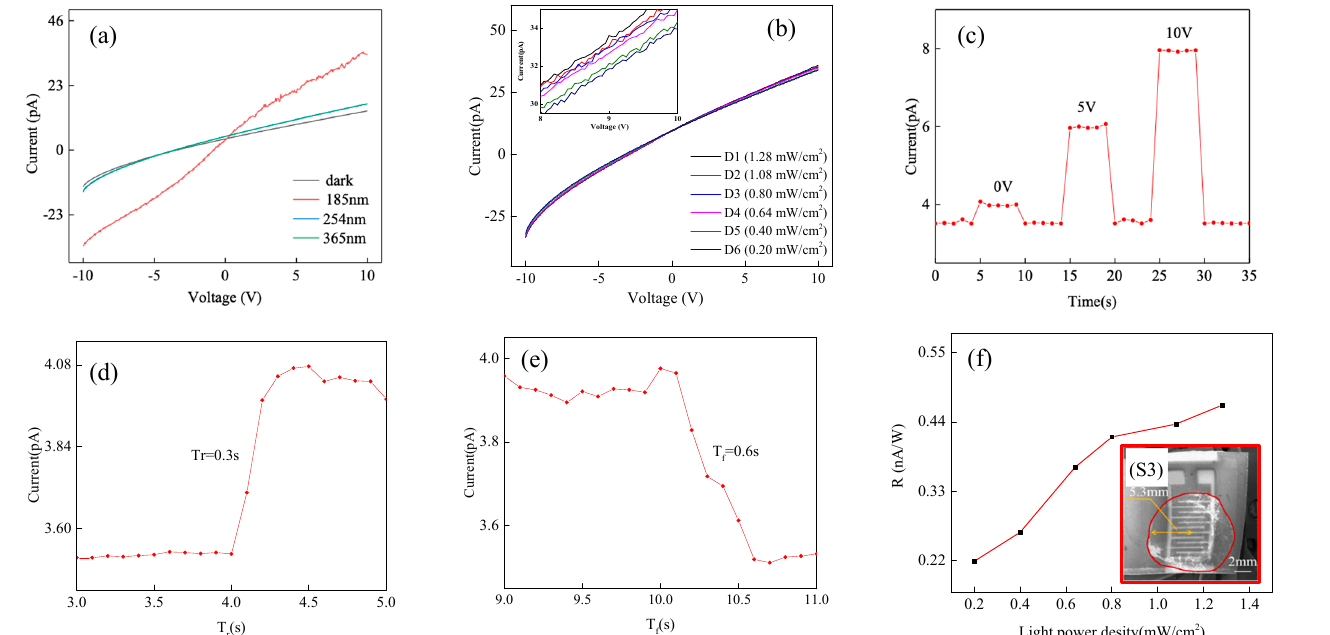
Figure 3. ( a ) I − V characteristic of the BNNRs-VUV dectector. ( b ) I − V characteristic of VUV detector with different light power densities. ( c ) I − t characteristic under different bias voltages. ( d ) Rise time of the detector. ( e ) Fall time of the detector. ( f ) Responsivity (S3: SEM image of the device. The active area is about 0.9 cm 2 ).